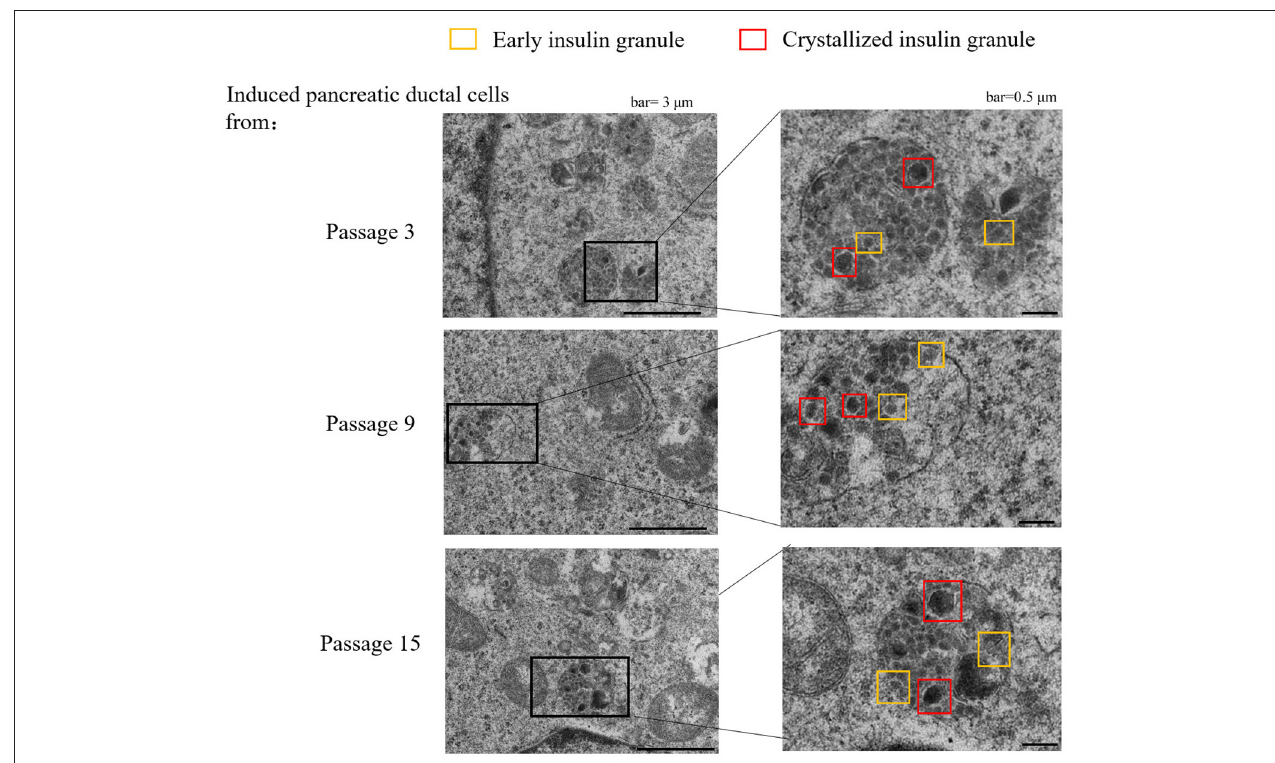
FIGURE 5 | Transmission electron microscope of granules in sectioned cells with representative crystallized insulin granules (red) and early insulin granules (yellow) in induced pancreatic ductal cells derived from different passages.